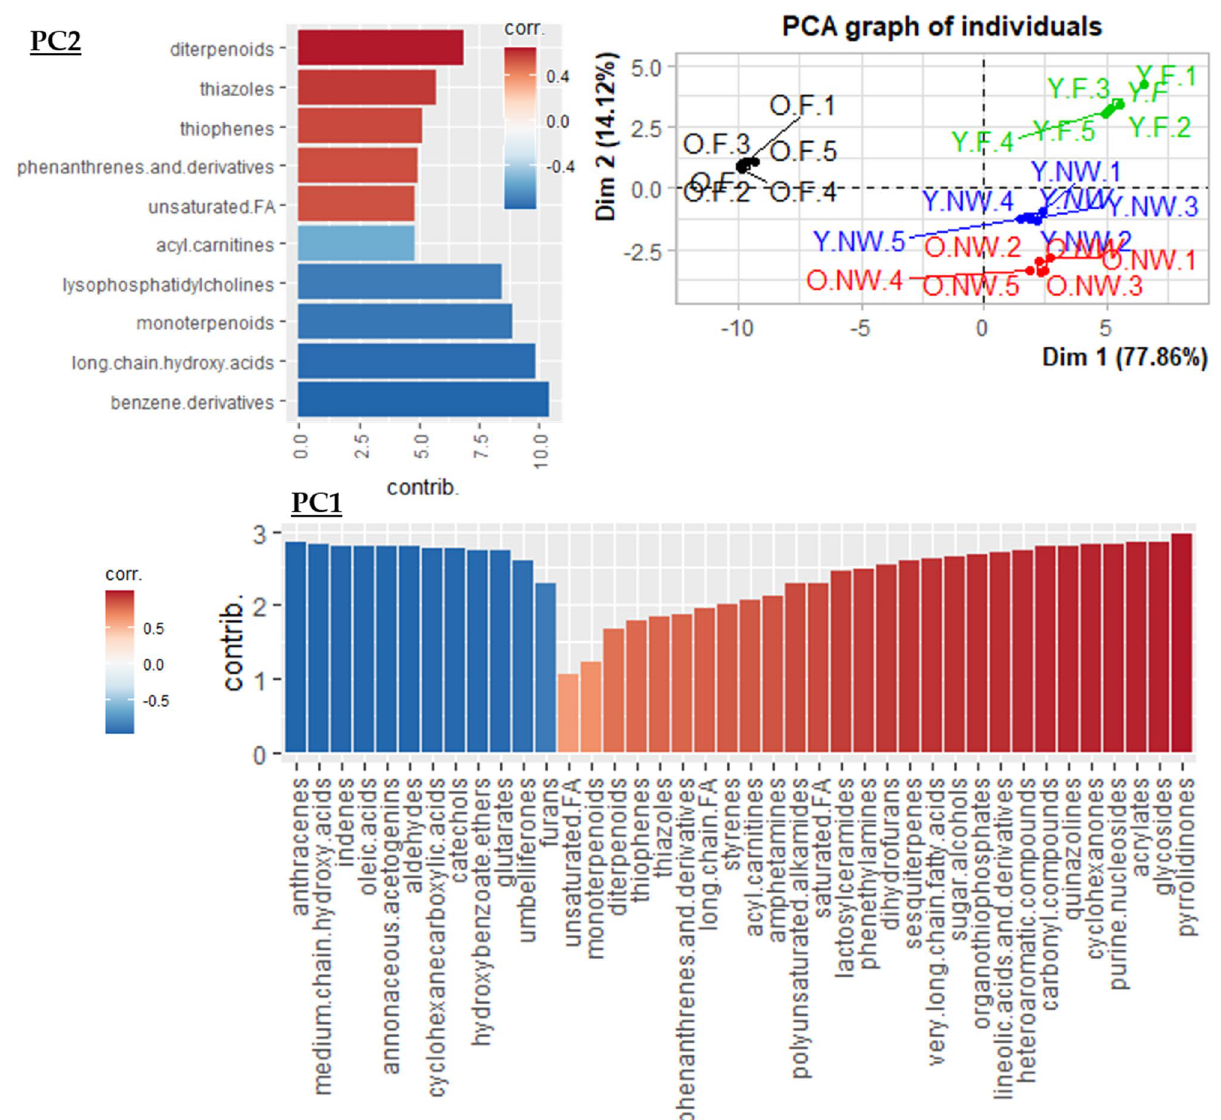
Figure 3. Classification-based PCA (PC1 and PC2). We ran a PCA with the metabolite classes as variables and explore the metabolomic differences amongst our four experimental groups of Lasius niger ants: Y.F (in green) = young foragers, O.F (in black) = old foragers, Y.NW (in blue) = young nest workers, O.NW (in red) = old nest workers. The bar plots represent the classes of metabolites and their correlation with the first and second principal component (PC1 and PC2) from blue (negatively correlated) to red (positively correlated), as well as their contribution (bar length). All metabolites showed are correlated. more than 50% to one of the two axis and cos 2 > 0.8. The list of metabolites is available in Table S6 (online material). FA stands for fatty